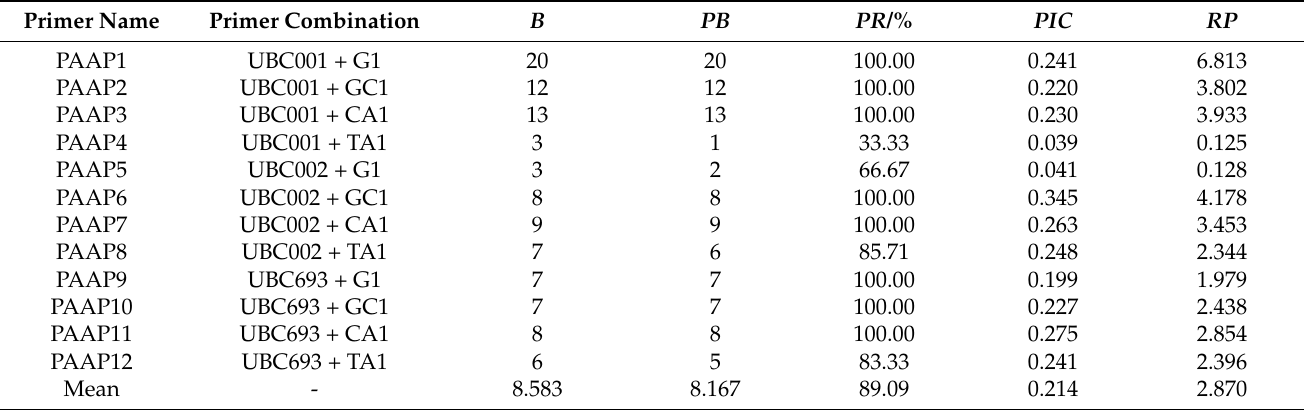
Table 2. Sequences and amplification results for PAAP